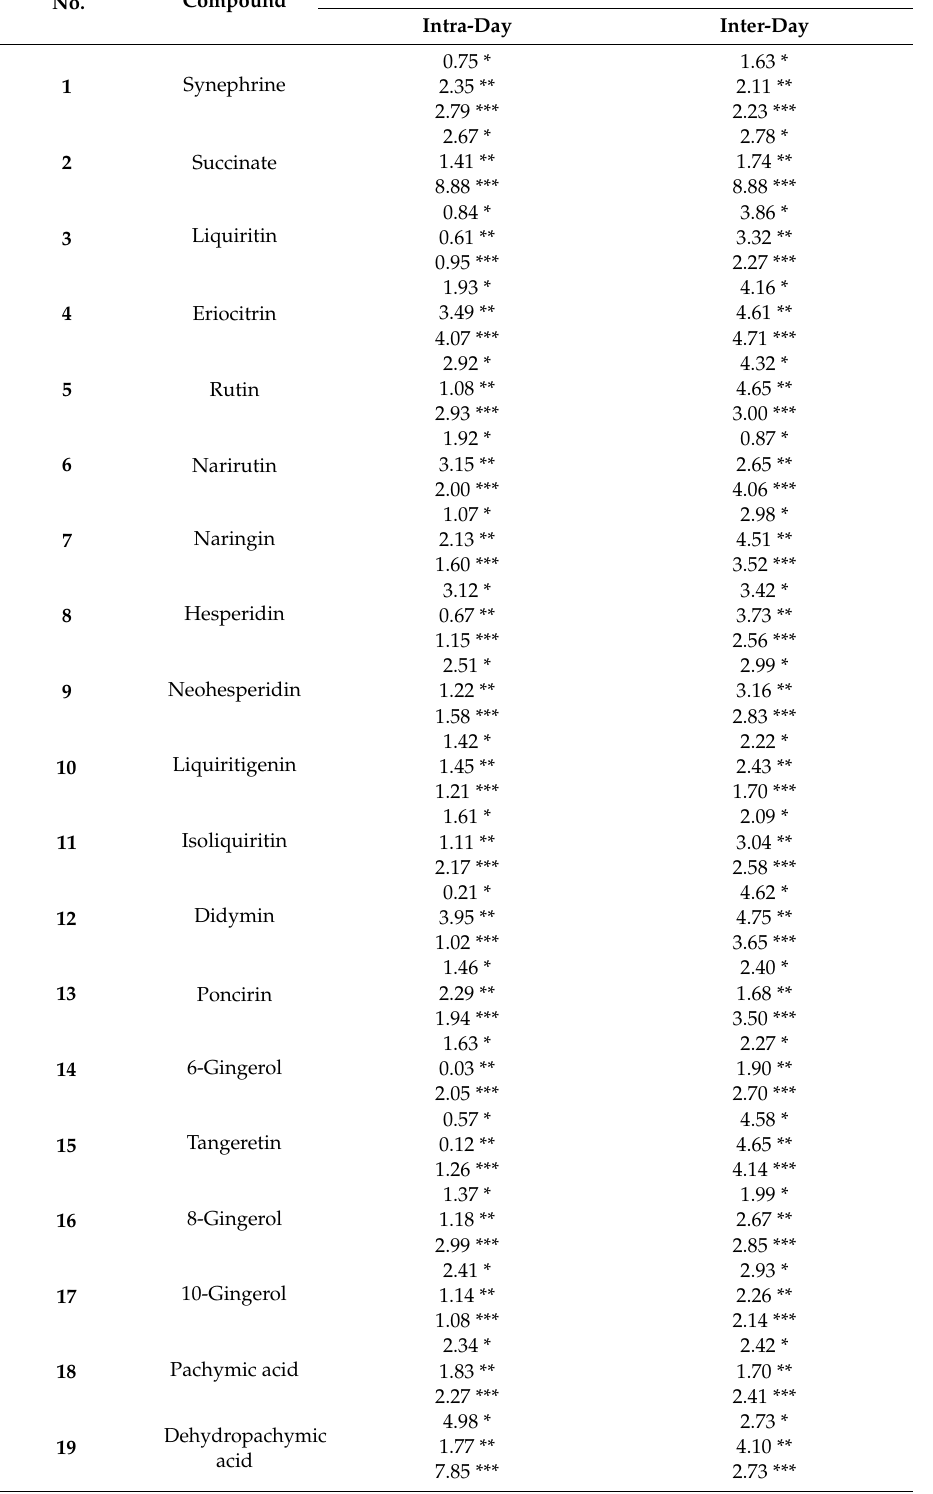
Table 3. Precisions of the 19